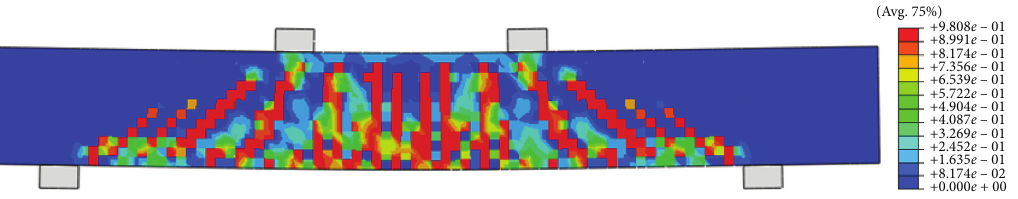
Figure 15: Typical crack pattern of finite element models.